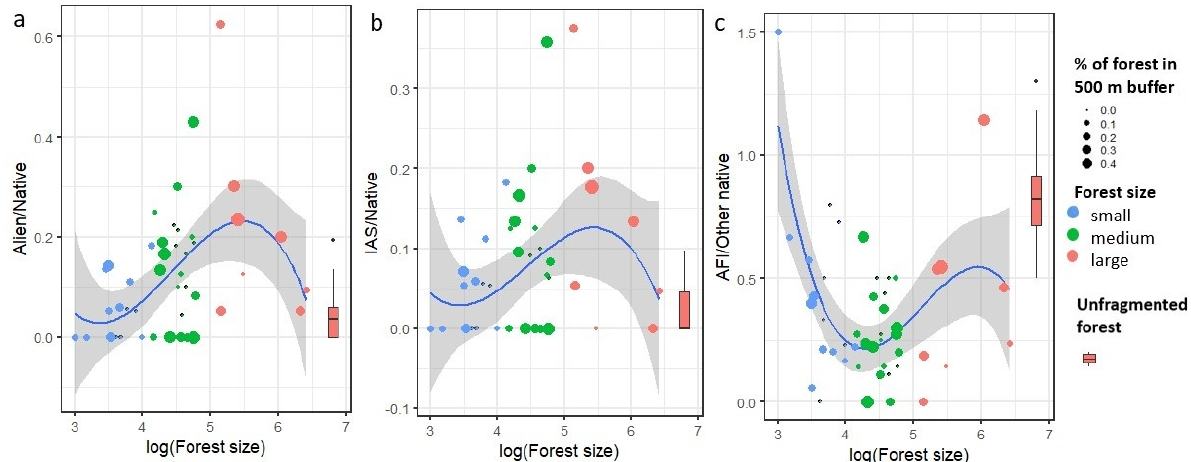
Figure 3. Effect of forest fragment size on plant composition assessed by the ratio between ( a ) alien and native plants, ( b ) invasive alien and native plants, and ( c ) ancient forest indicator plants and the rest of native plants. The color and size of the dots correspond to the forest fragment size group and % of forest cover in 500 m buffer. Control unfragmented forest Murska šuma is shown by a bar (minimum, 1st quartile, median, 3rd quartile, maximum).